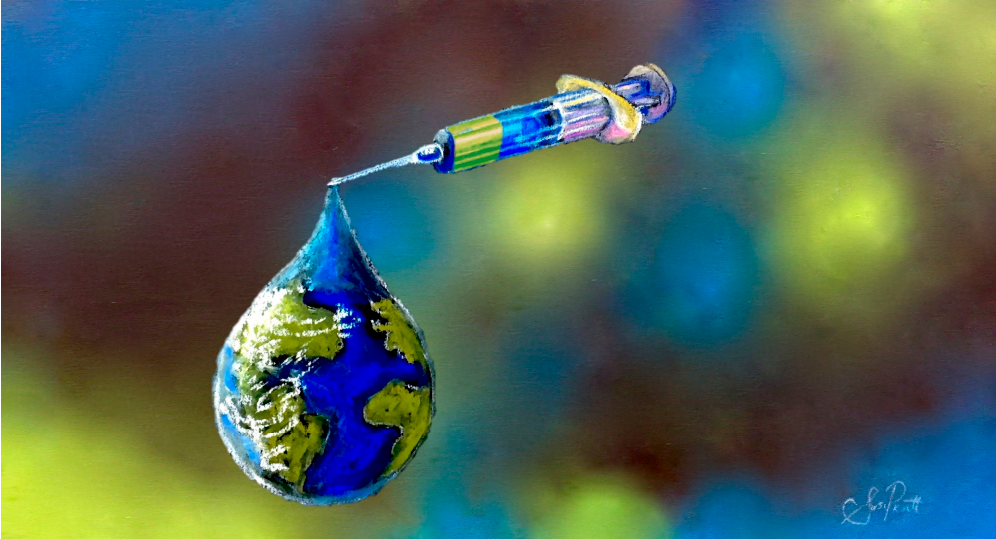
Figure 1. Immunization for Planetary Health: In addition to developing infectious disease vaccines,